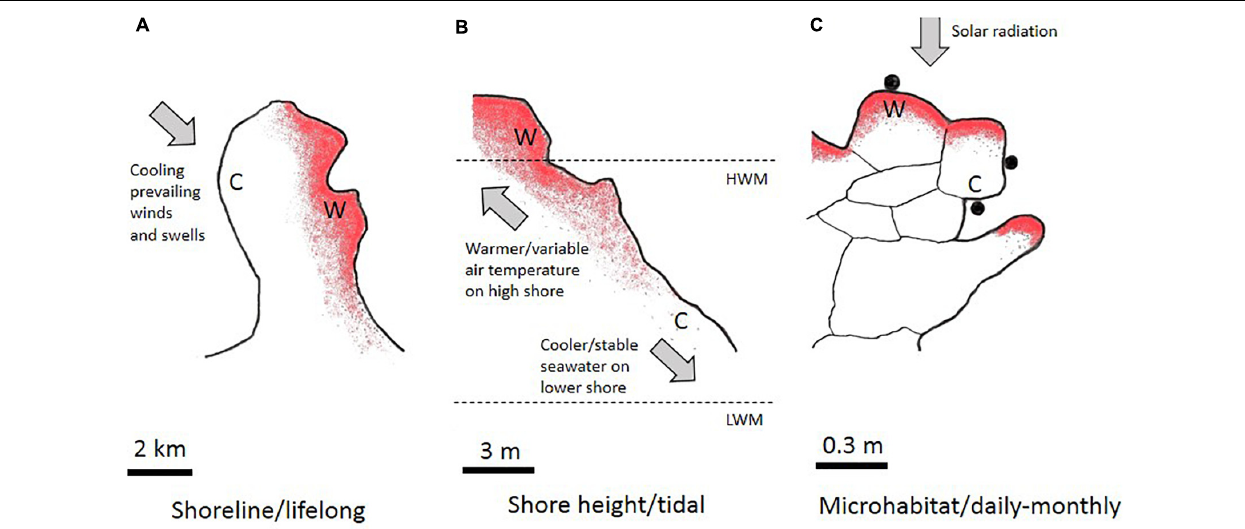
FIGURE 1 | Concept for spatiotemporal scaling of rocky-shore thermal heterogeneity. (A) Aerial view of a coastal headland (2 km scale) showing the heat-load distribution (more intense red shading represents greater heat-load). One side of the headland (C) is exposed to prevailing winds and swells whereas the other side (W) is sheltered. Organisms experience either cooler or warmer shoreline conditions throughout their lifetimes. (B) Vertical profile of a rocky-shore (3 m scale), showing greater heat-loading in the higher shore (W) due to the variable air temperature. Relatively stable, cooler conditions (C) are experienced in the lower-shore. HWM, high water mark; LWM, low water mark. (C) Microhabitats of resting snails (0.3 m scale) showing the effect of solar heating on heat loads. Snails (solid circles) may retain these positions for months in the supratidal or may be redistributed after splashing during spring high-water or high monsoon swell conditions. Snails are primarily heated from the rock surface (see Marshall and Chua,